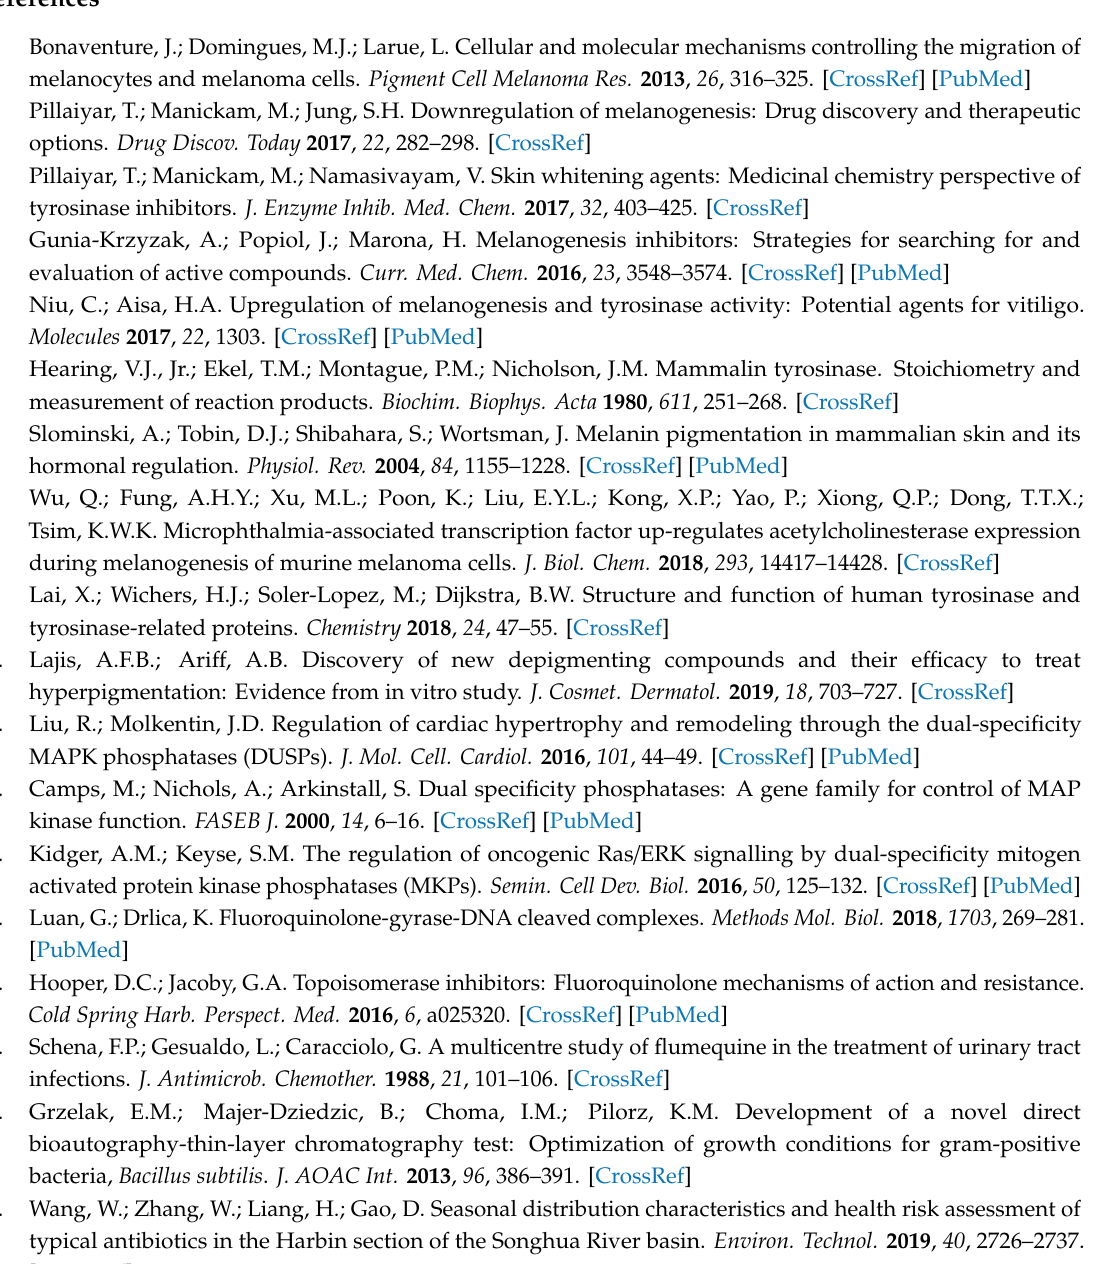
docking comparison of flumequine with DUSP16, Table S1: Classification of results gained from the docking of flumequine into